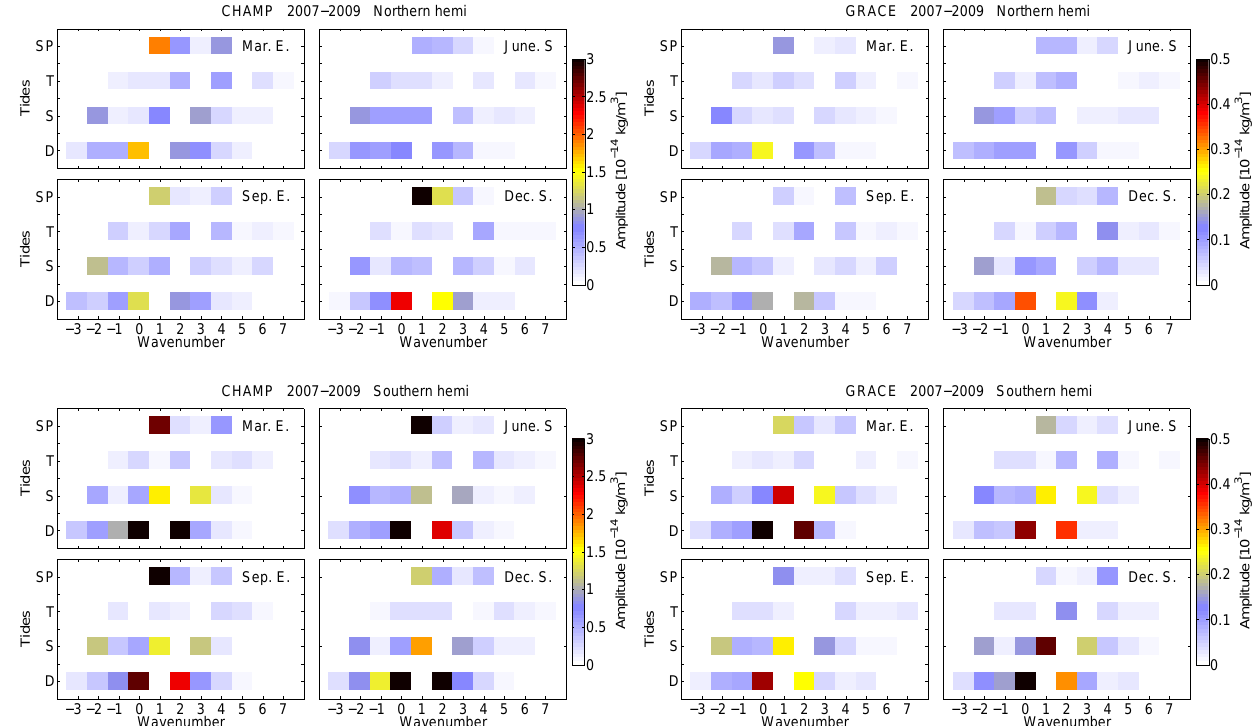
Figure 2. Spectra of the tidal and stationary components in mass density for four seasons in the Northern (top) and Southern (bottom) hemispheres both from CHAMP (left) and GRACE (right)